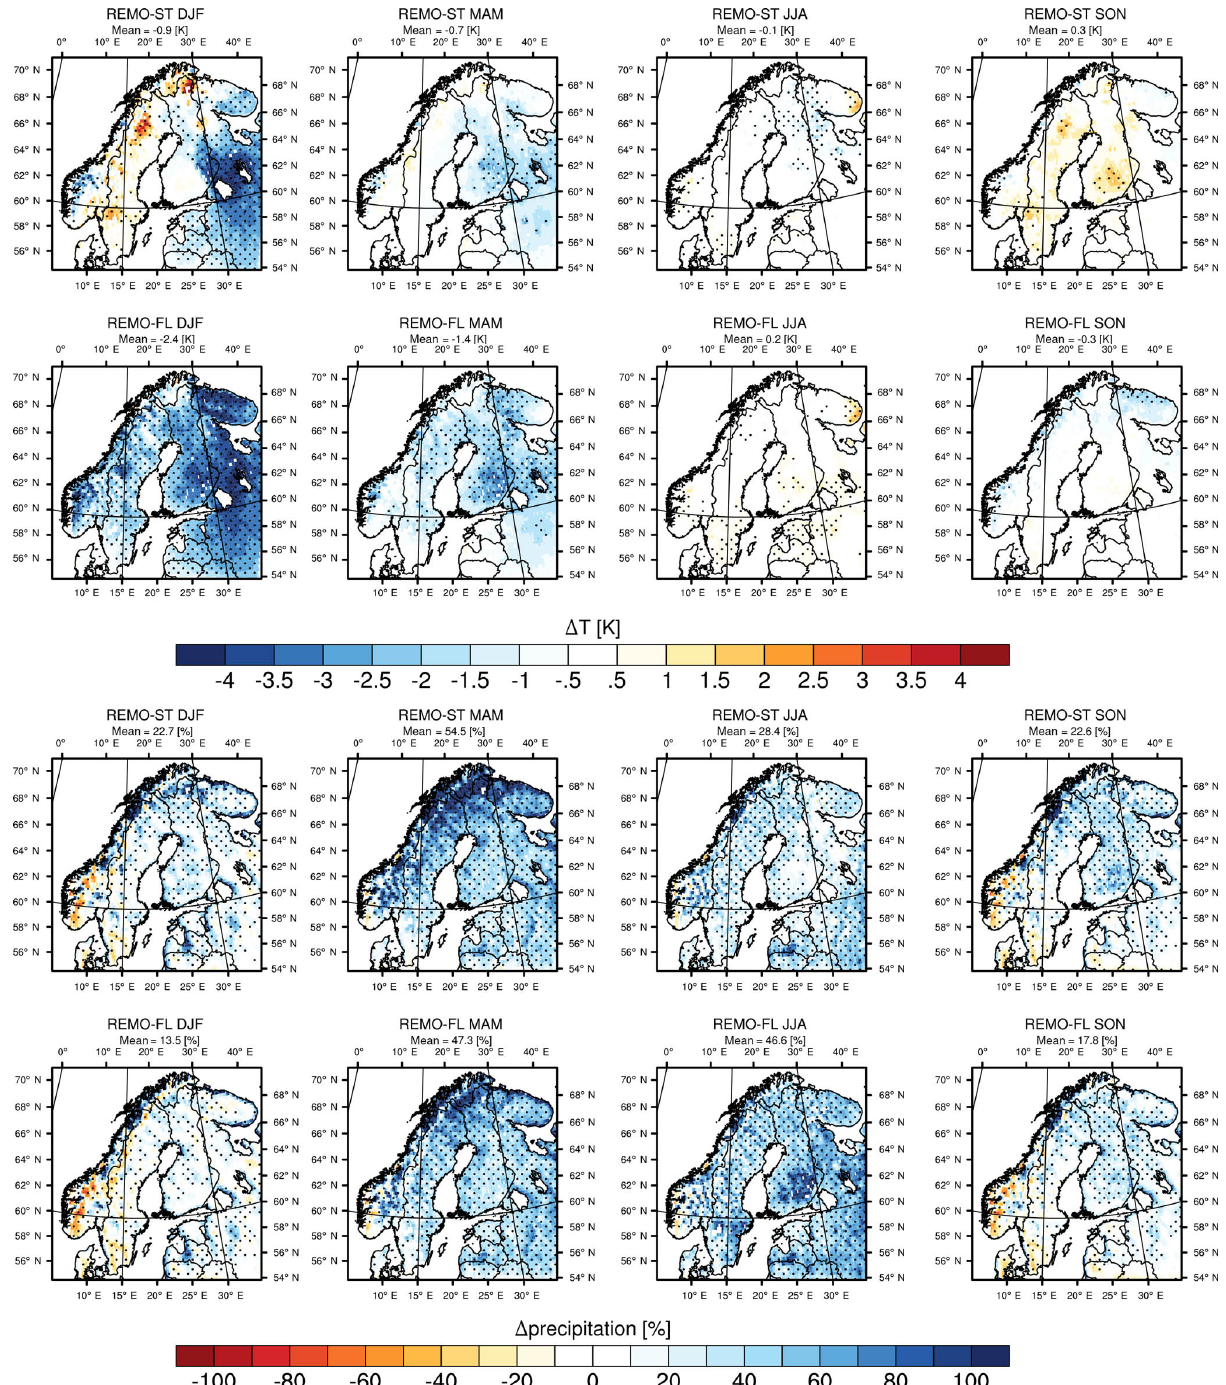
Figure 3. The 2m temperature and precipitation biases of standard REMO (REMO-ST) and REMO with the FLake module (REMO-FL) compared to E-OBS data. The seasonally averaged results are for the time period of October 1979–March 2015. Dots indicate statistically significant differences with p values < 0 .